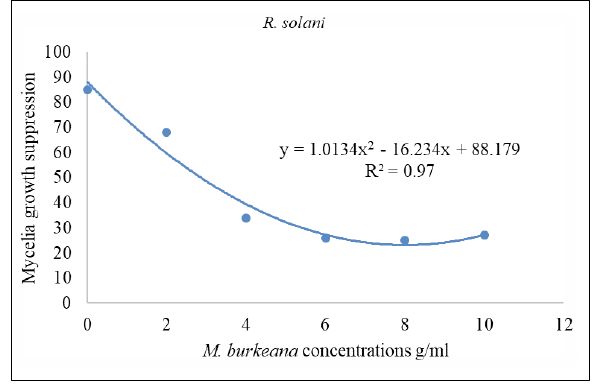
Quadratic relationship between mycelia growth of Rhizoctonia solani and Monsonia burkeana plant extract concentration.